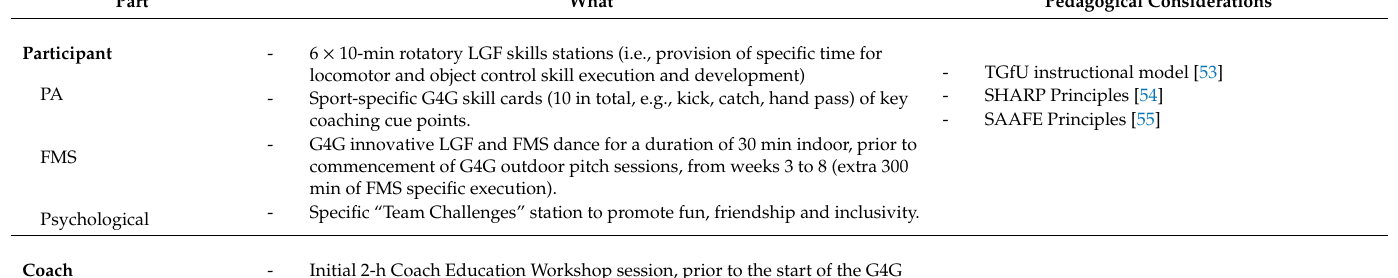
Table 1. Overview of the research informed Gaelic4Girls intervention group 1 program components with associated pedagogical considerations.